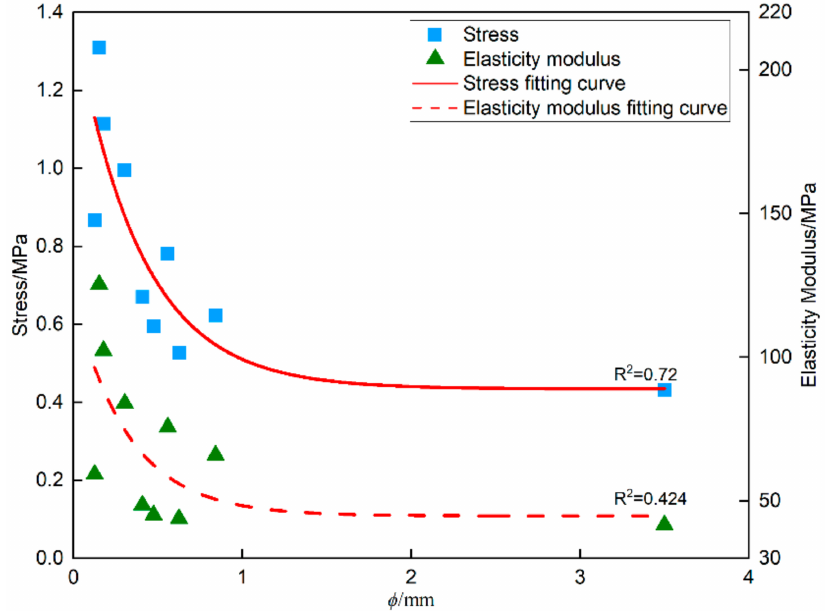
Figure 6. Relationship between converted particle size, uniaxial compressive strength, and elastic